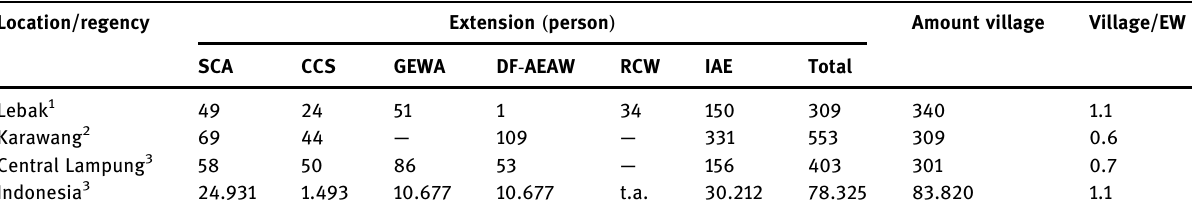
Table 1: Number of EWs SCA, CCS, GEWA, DF - AEAW, RCW, and IAE at the research site, 2021 Location/regency Extension ( person )